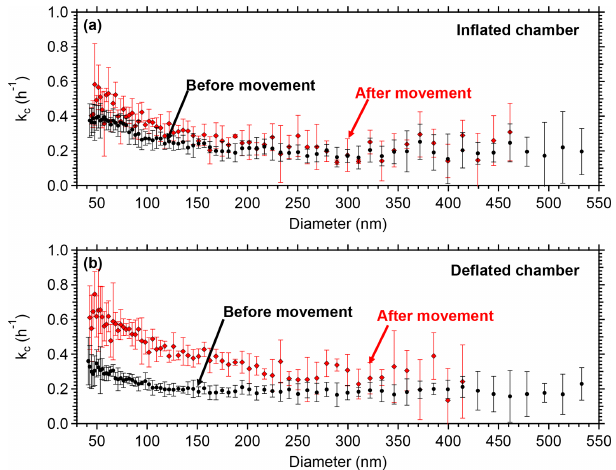
Figure 5. Coagulation-corrected particle wall loss rate constant as a function of particle size for the two chambers after the movement (a) in the partially inflated chamber and (b) in the deflated chamber. The error bars represent 1 standard